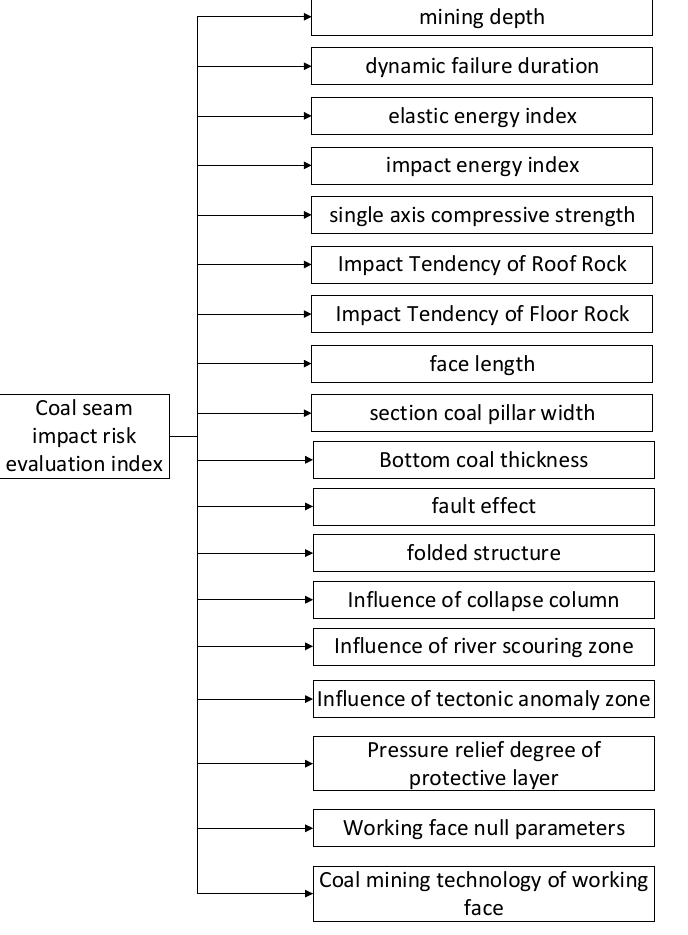
Figure 1. Evaluation Index of Coal Seam Impact Risk.